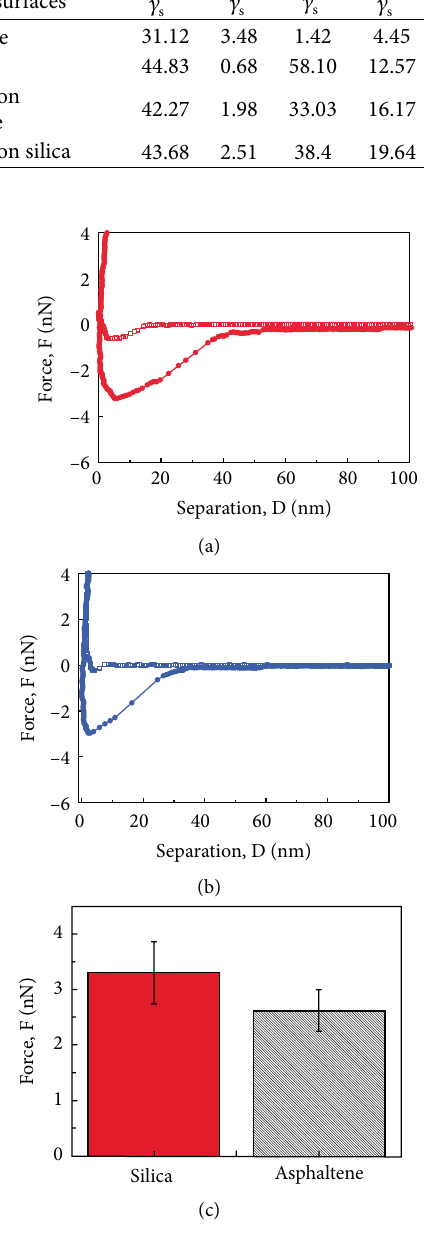
Figure 3: Typical force-distance profiles of the HMPAM-coated silica probe on surfaces in 100 mM KCl solution: (a) silica, (b) asphaltene, and (c) summary of the